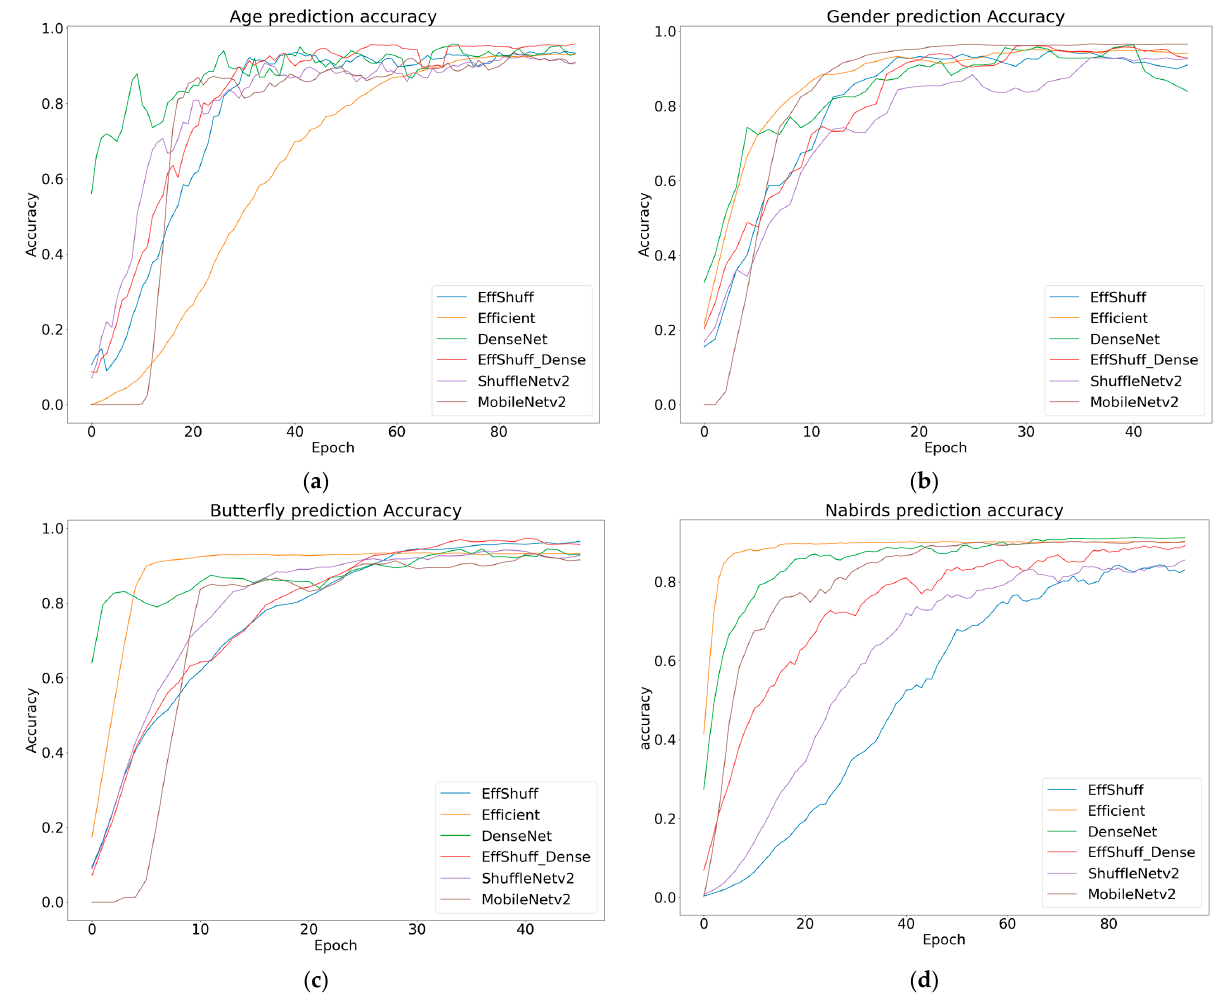
Figure 8. Accuracy comparison of EffShuffNet, EffShuffDenseNet and other models in validation scheme. ( a ) The Audience dataset: age prediction; ( b ) the Audience dataset: gender prediction; ( c ) the Butterfly & Moths dataset: class prediction; ( d ) the NA Birds dataset: class prediction.